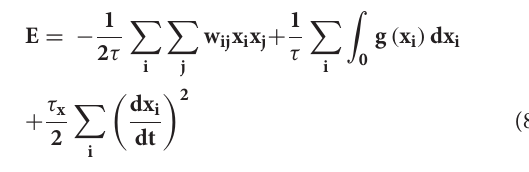
U i denotes the potential of the ID function model of the neuron. In Equation (7), the first term denotes the inertia and the second term denotes the friction. If g(x i ) is an N-shaped function, then the area where dg ( x ) for specific values of x i is called the is less than − τ x τ dx i negative resistance